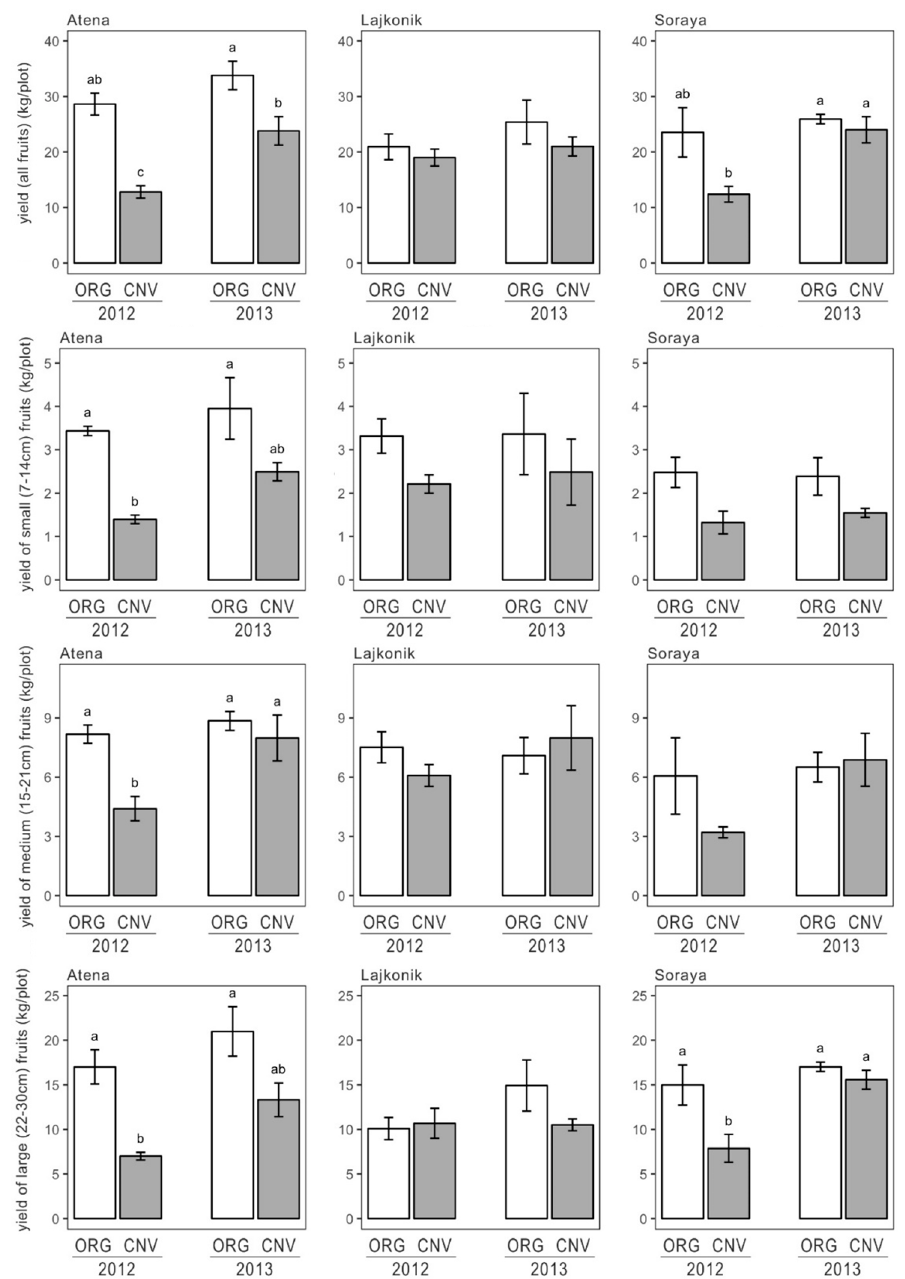
Figure 3. Total yield (kg / plot = tons / ha) of all (7–30 cm), small (7–14 cm), medium (15–21 cm) and large (22–30 cm) organic (ORG) and conventional (CNV) courgette fruits of Atena, Lajkonik and Soraya cultivars grown in two consecutive years. Data are presented as means with standard errors. Within each cultivar, bars marked with the same letters are not significantly di ff erent at the 5% level of